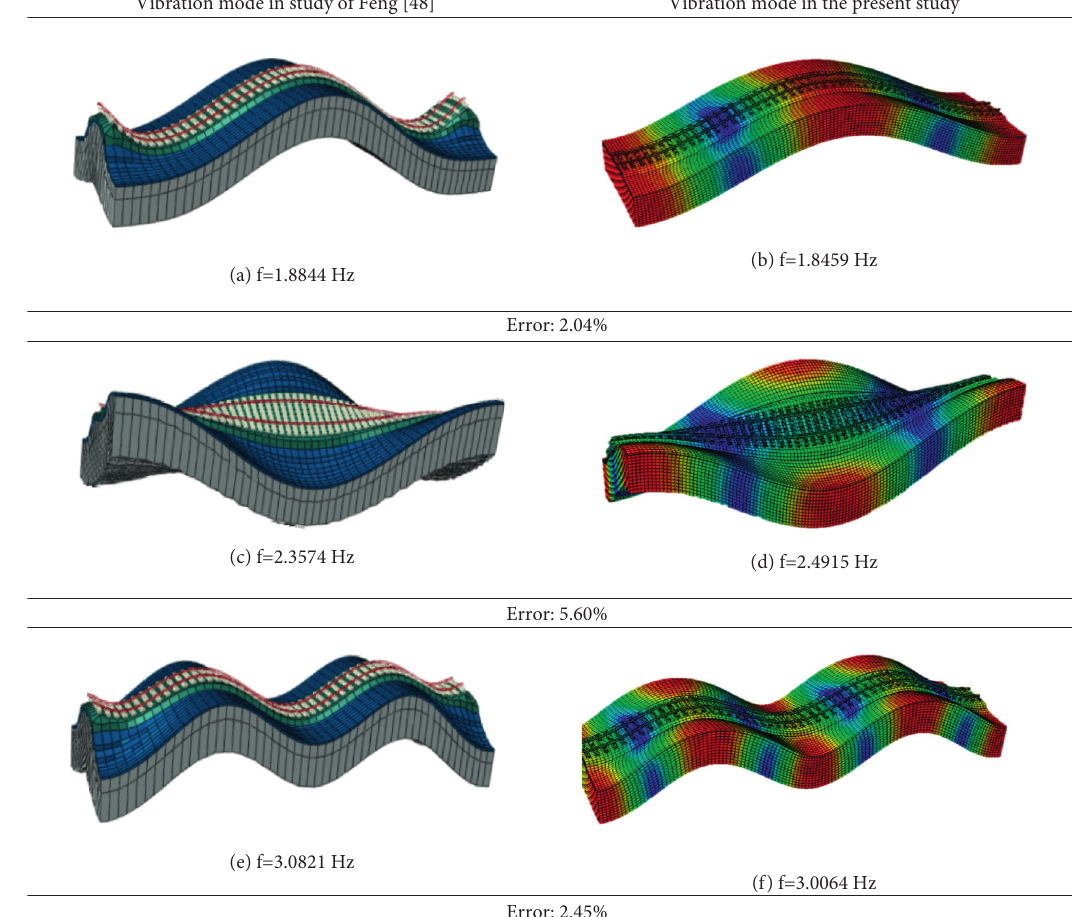
Figure 3: The sensitive vibration mode diagram of track structure: (a) f � 1.8844Hz, (b) f � 1.8459Hz, (c) f � 2.3574Hz, (d) f � 2.4915Hz,